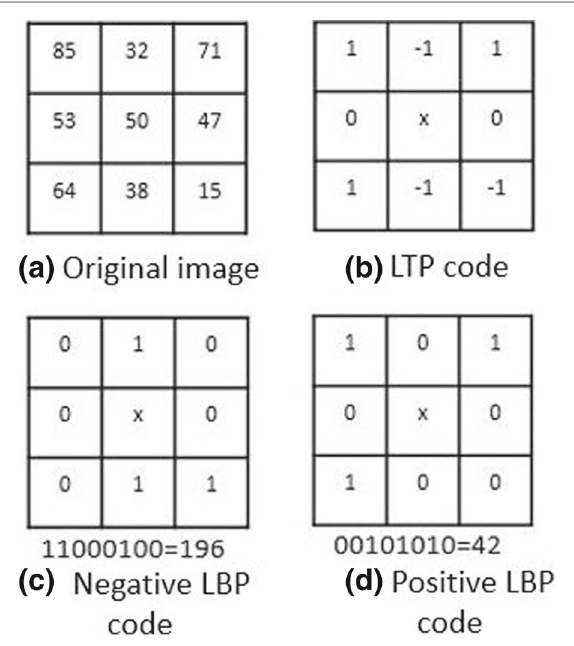
Fig. 13 a – d LTP code with τ = ± 5 and corresponding positive and negative LBP